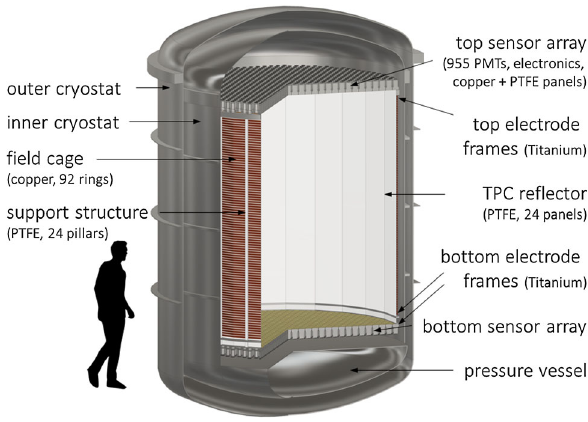
Table 1 List of detector components included in the geant4 geometry model of DARWIN stating their material composition and total